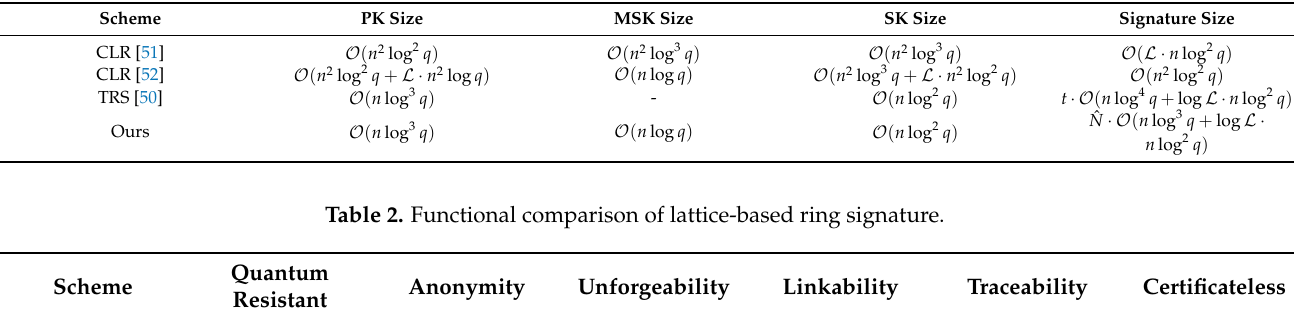
Table 1. Theoretical estimation of key sizes and signature sizes of lattice-based ring signature.